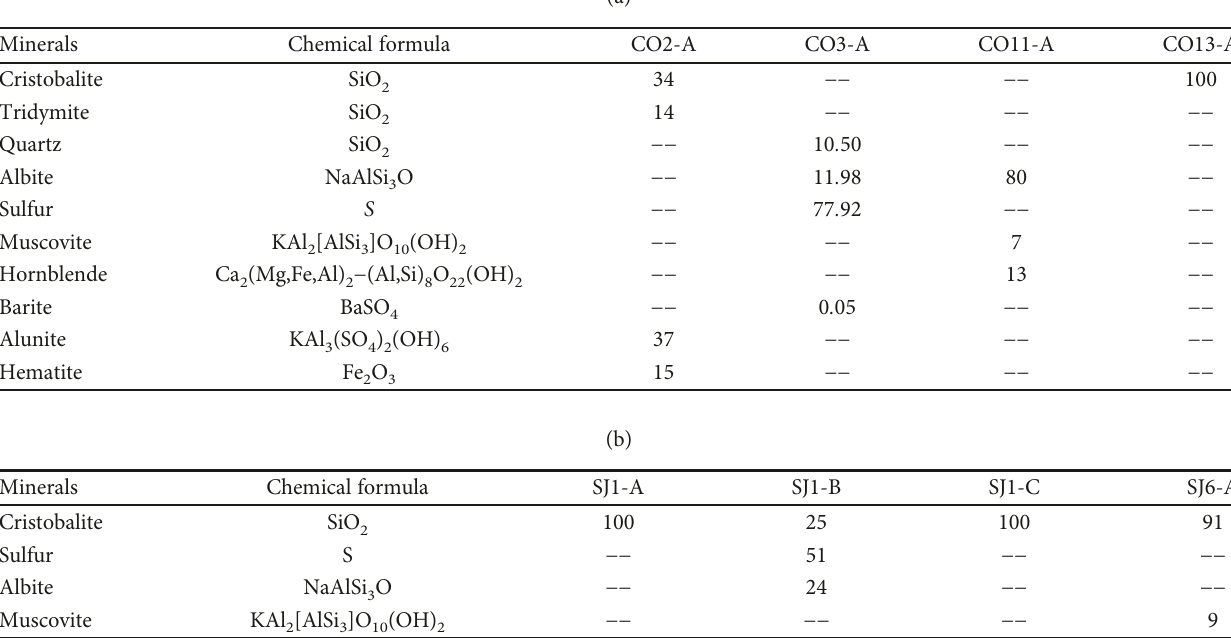
Table 5: Analysis of quanti fi cation of minerals in samples from the (a) Coconuco sector and (b) San Juan